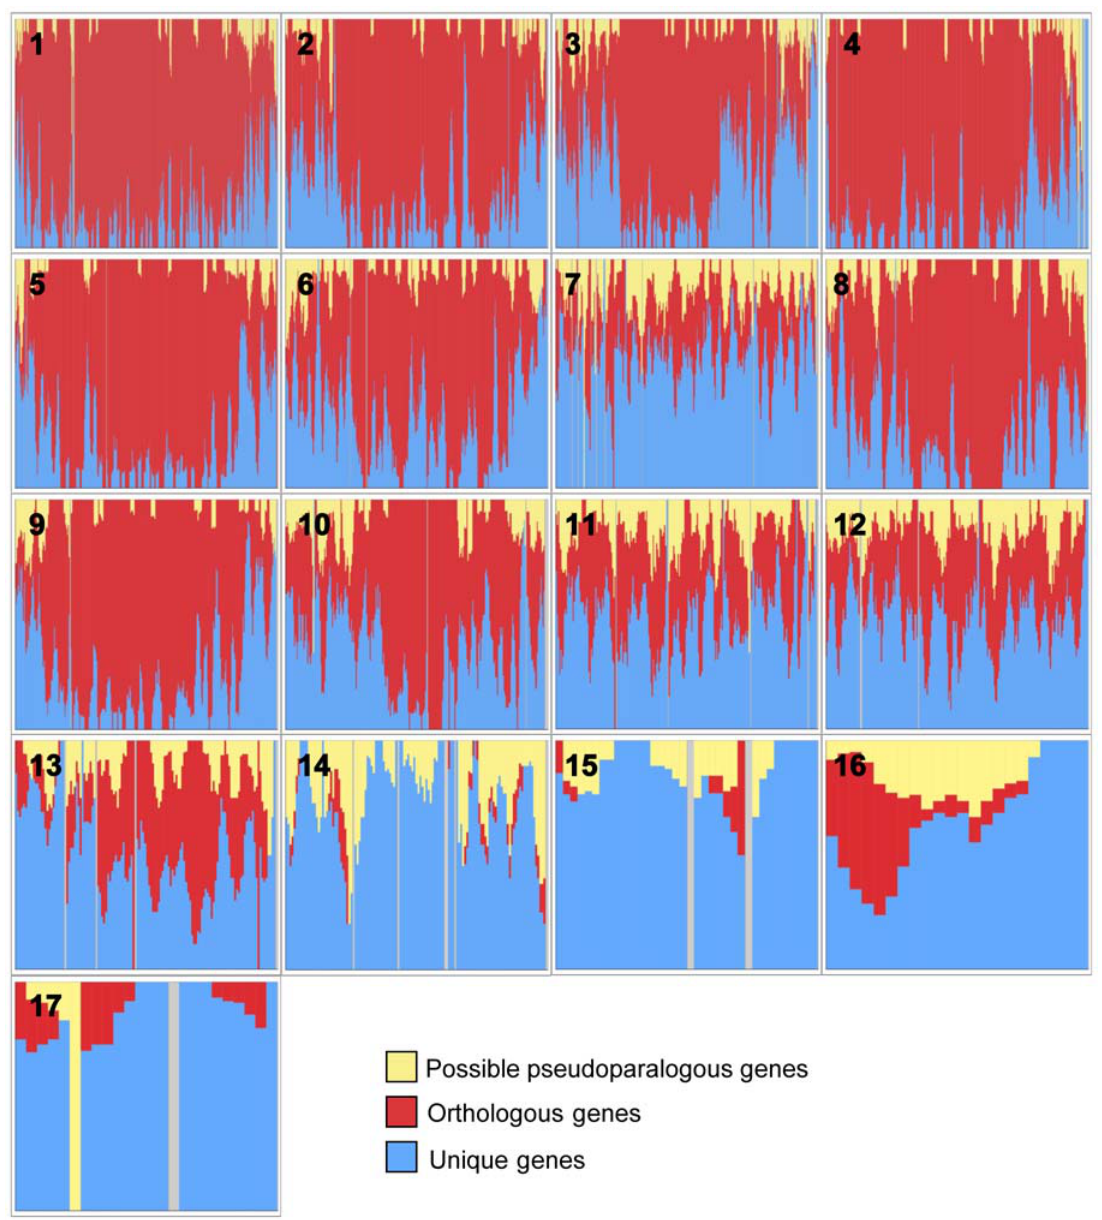
Figure 9. Distribution of orthologs, possible pseudoparalogs, and unique genes on each of the chromosomes of N.haematococca MPVI. Compositional statistical analysis using an additive log-ratio transformation [102] reveals that the distribution of genes within the three classes is statistically different on chromosomes 14, 15, and 17 than on the other chromosomes (p=1.05e-5).